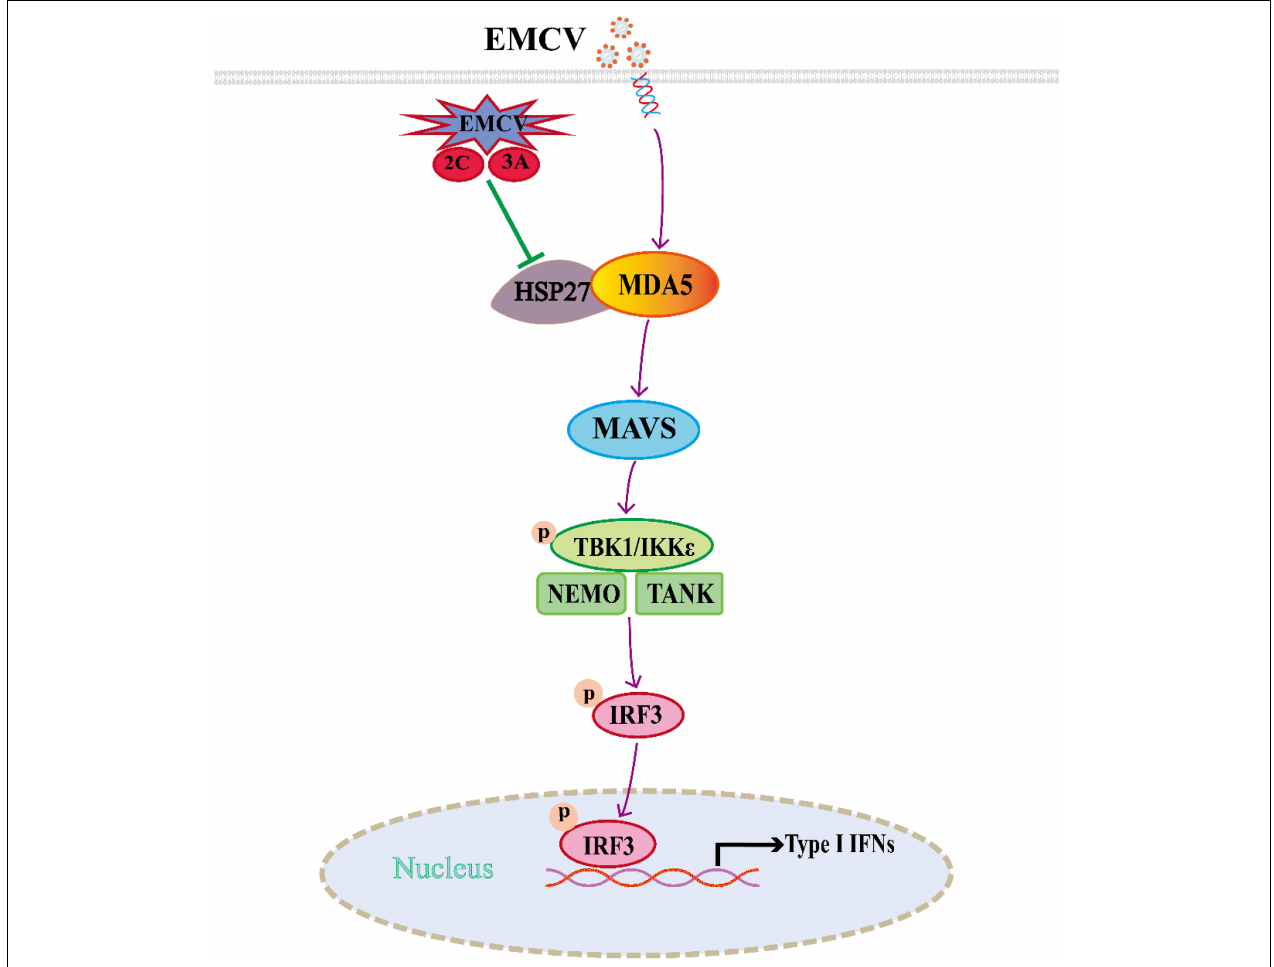
FIGURE 8 | Schematic illustration of HSP27 as a molecular chaperone that stabilizes melanoma differentiation-associated gene 5 (MDA5) expression and positively regulates the type I IFN signaling pathway triggered by encephalomyocarditis virus (EMCV).